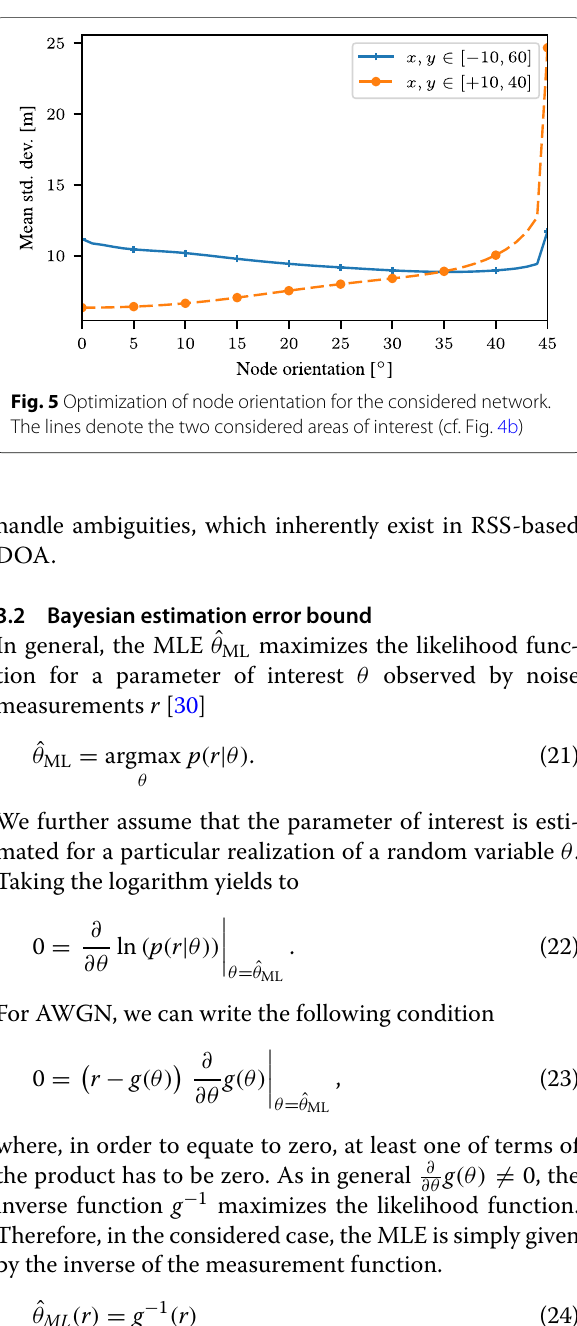
topology optimization of the WSN is not only subject to